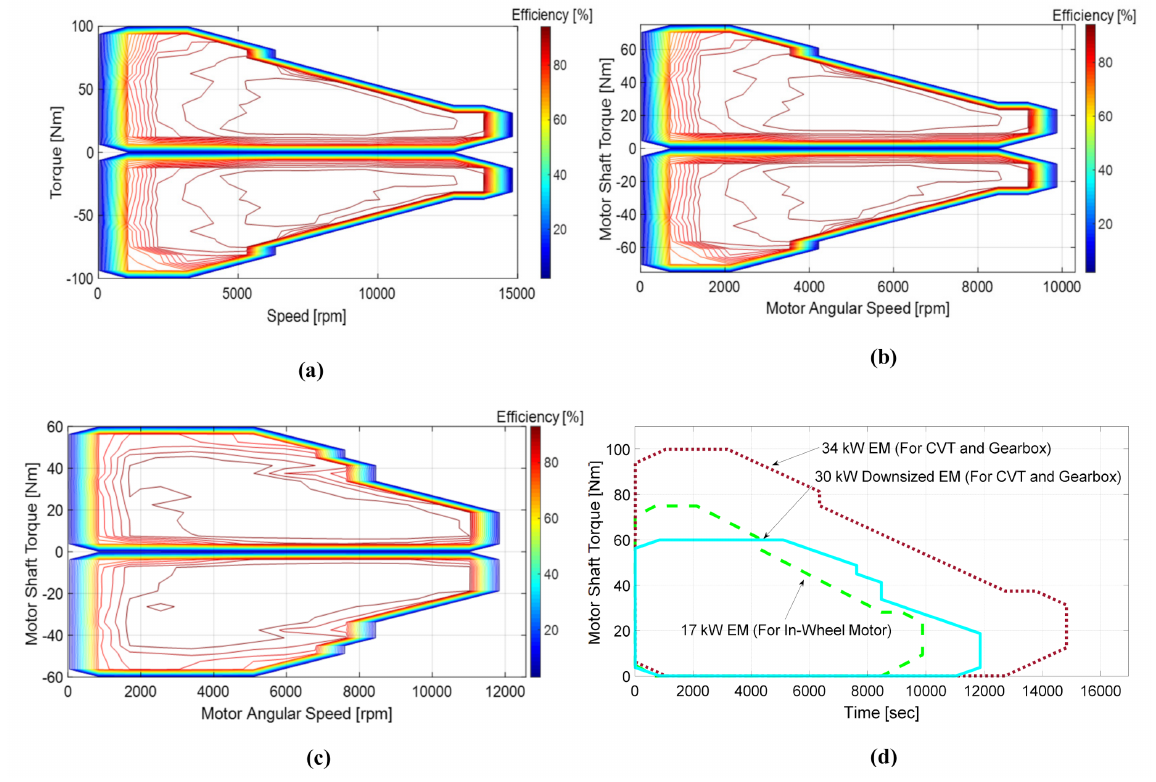
Figure A1. ( a ) Efficiency of electric motor for 1G, 2G, and CVT; ( b ) Efficiency of in-wheel motor with RESC and without RESC; ( c ) Efficiency map for downsized electric motor for CVT; ( d ) Power cycle comparison for the used electric